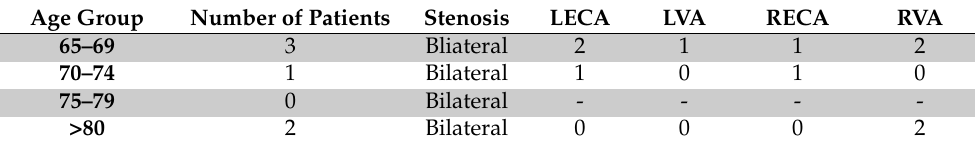
Table 6. Pathways of collateral circulation in patients with bilateral ICA